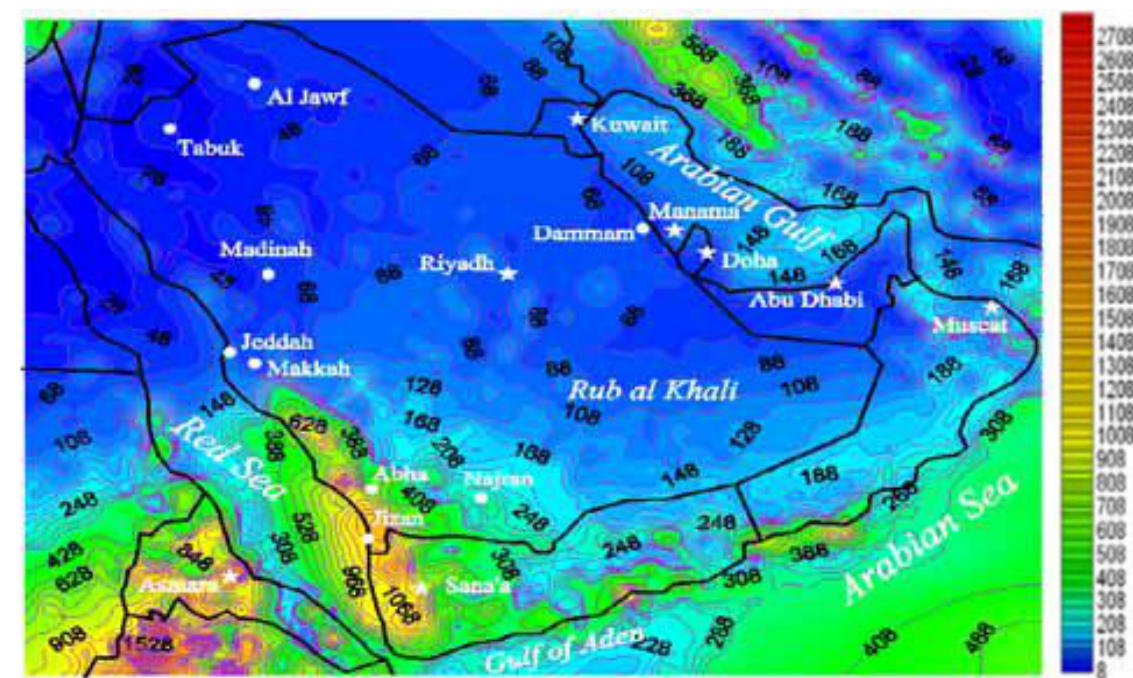
Figure 19. The spatial distribution pattern of the mean annual total precipitation over the 2070–2100 period [39].